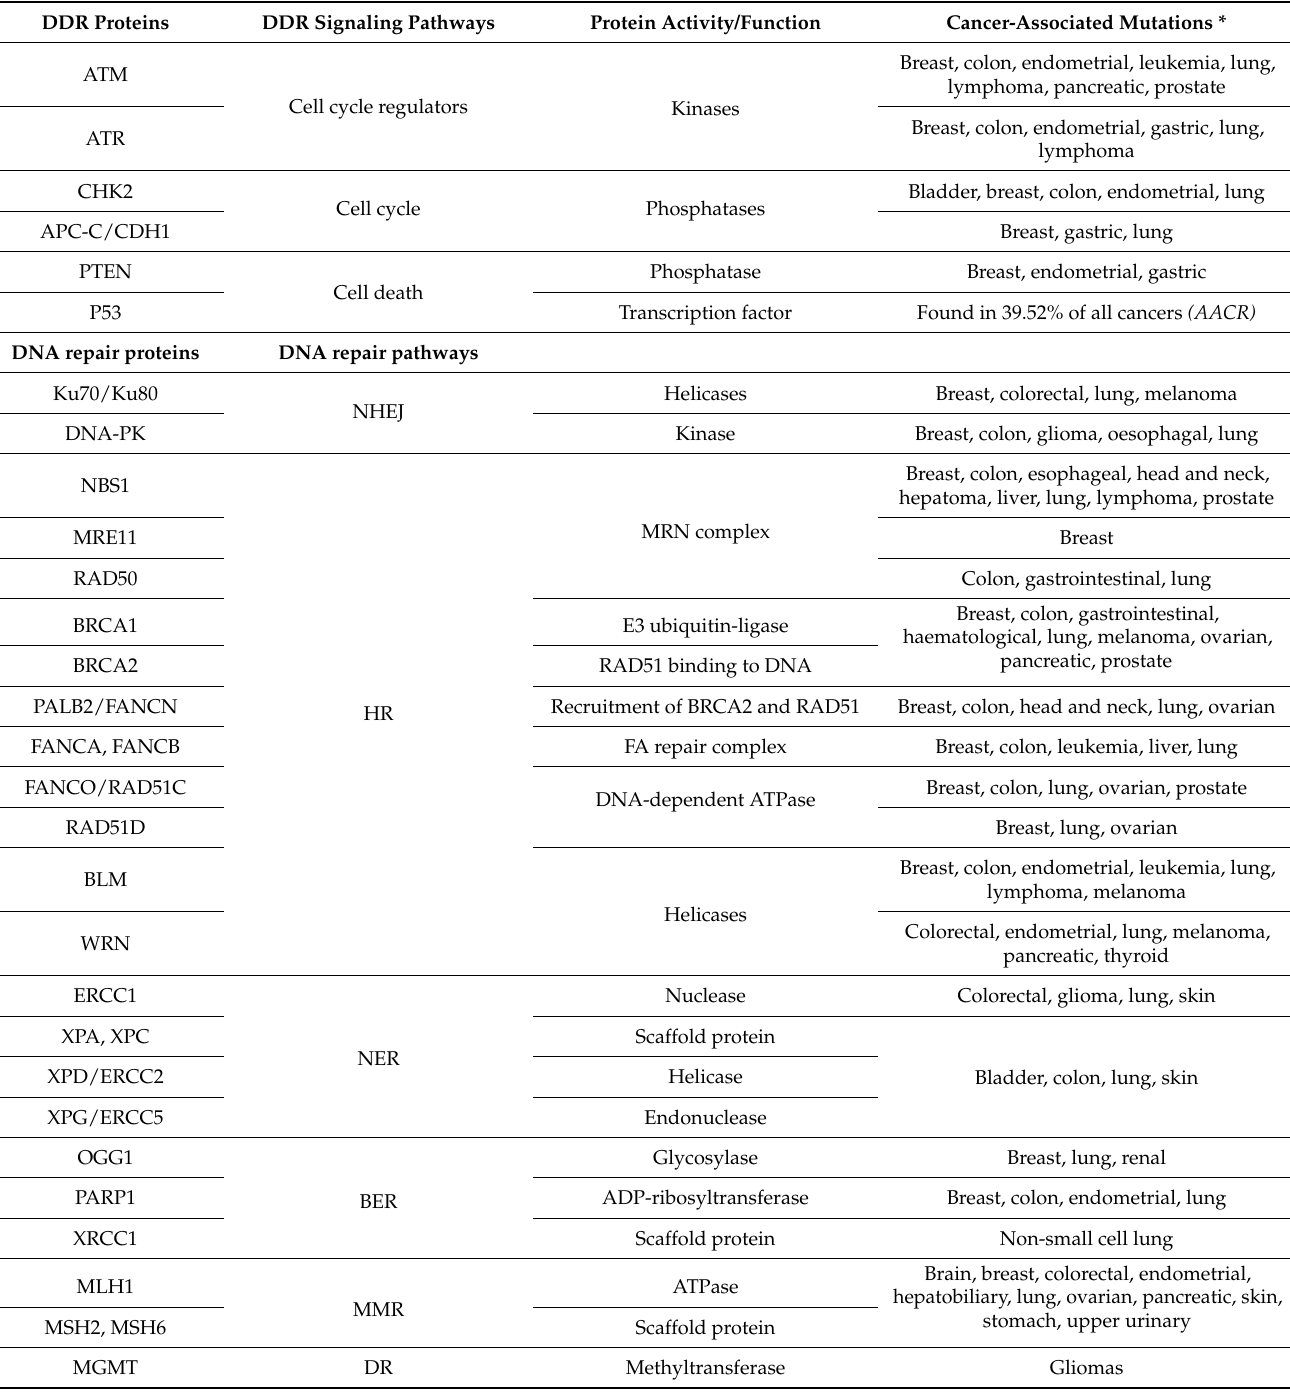
Table 1. DDR-proteins mutations associated to various